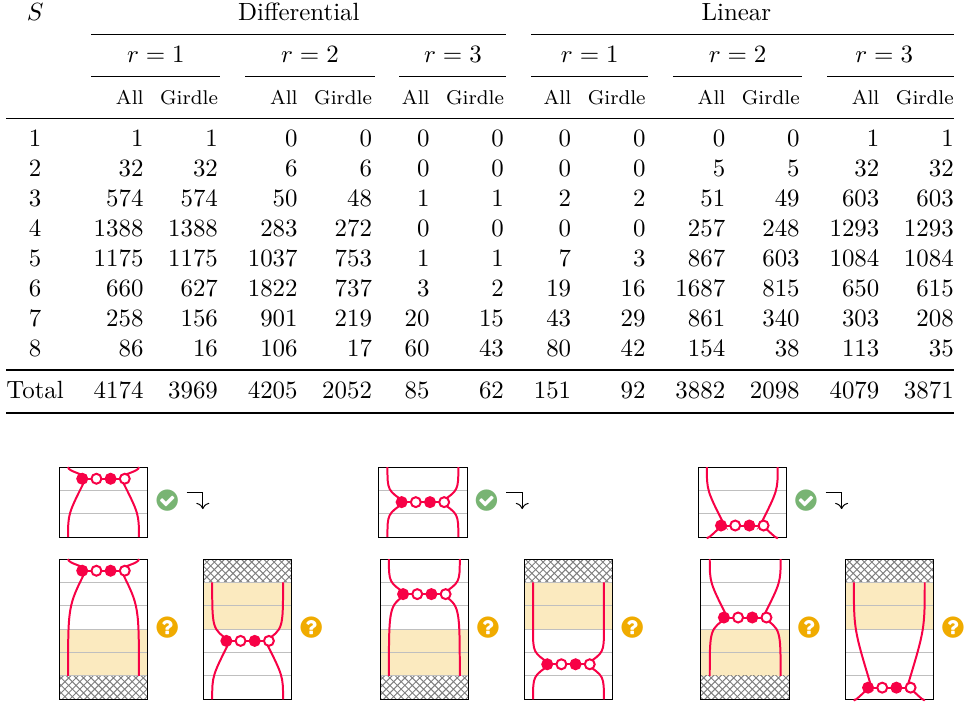
Table 8: Overview of filtered results after 3 rounds for the differential and linear model with girdle weight S ≤ 8 in round r ∈ { 1 , 2 , 3 }